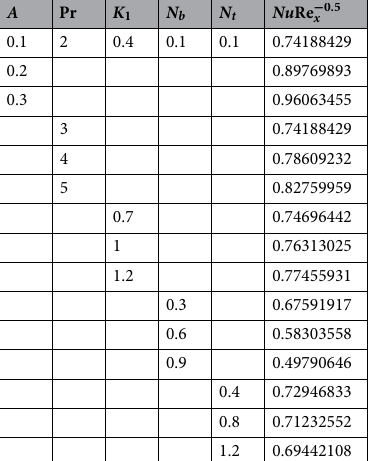
Table 3. Numeric values of Nu Re − 0.5